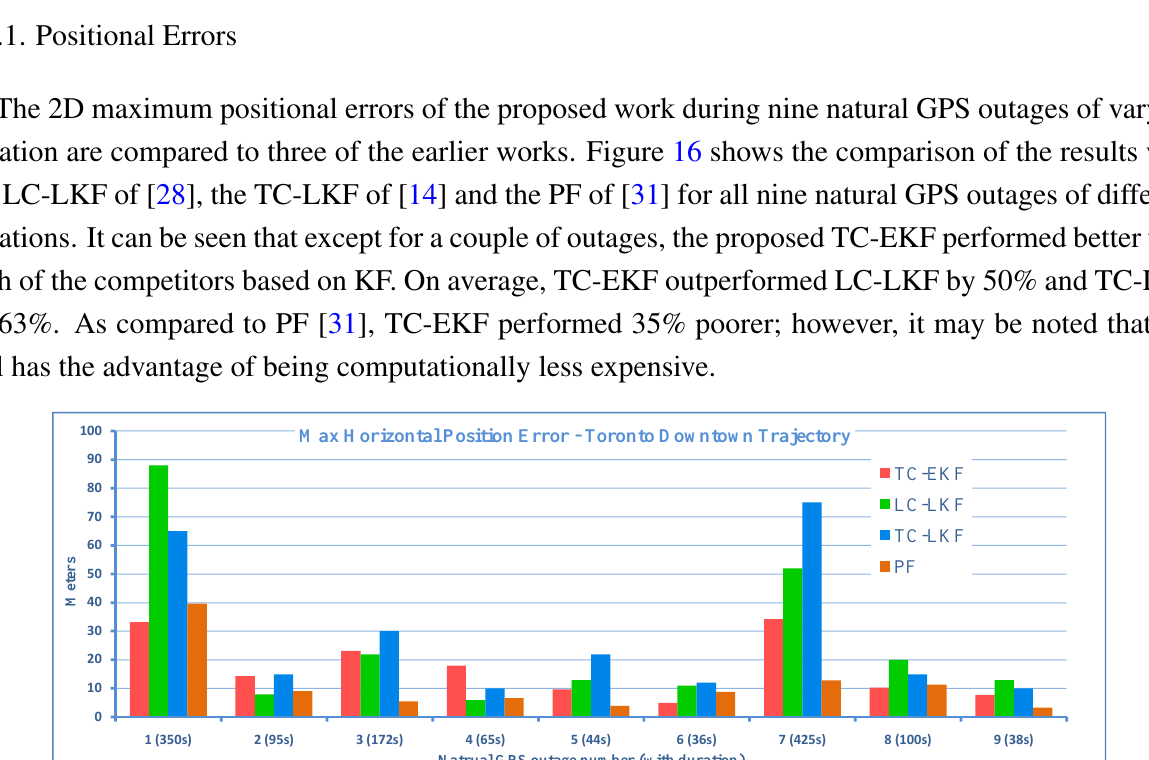
Figure 15. Availability of the satellites during the Toronto downtown trajectory.